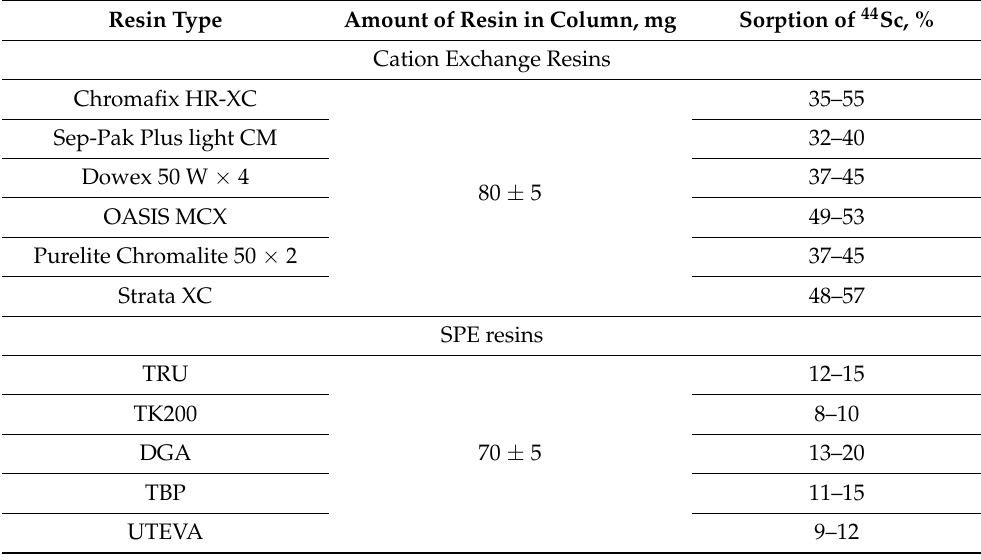
Table 3. The results of 44 Sc sorption on different resins from TEVA-based 44 Ti/ 44 Sc generator